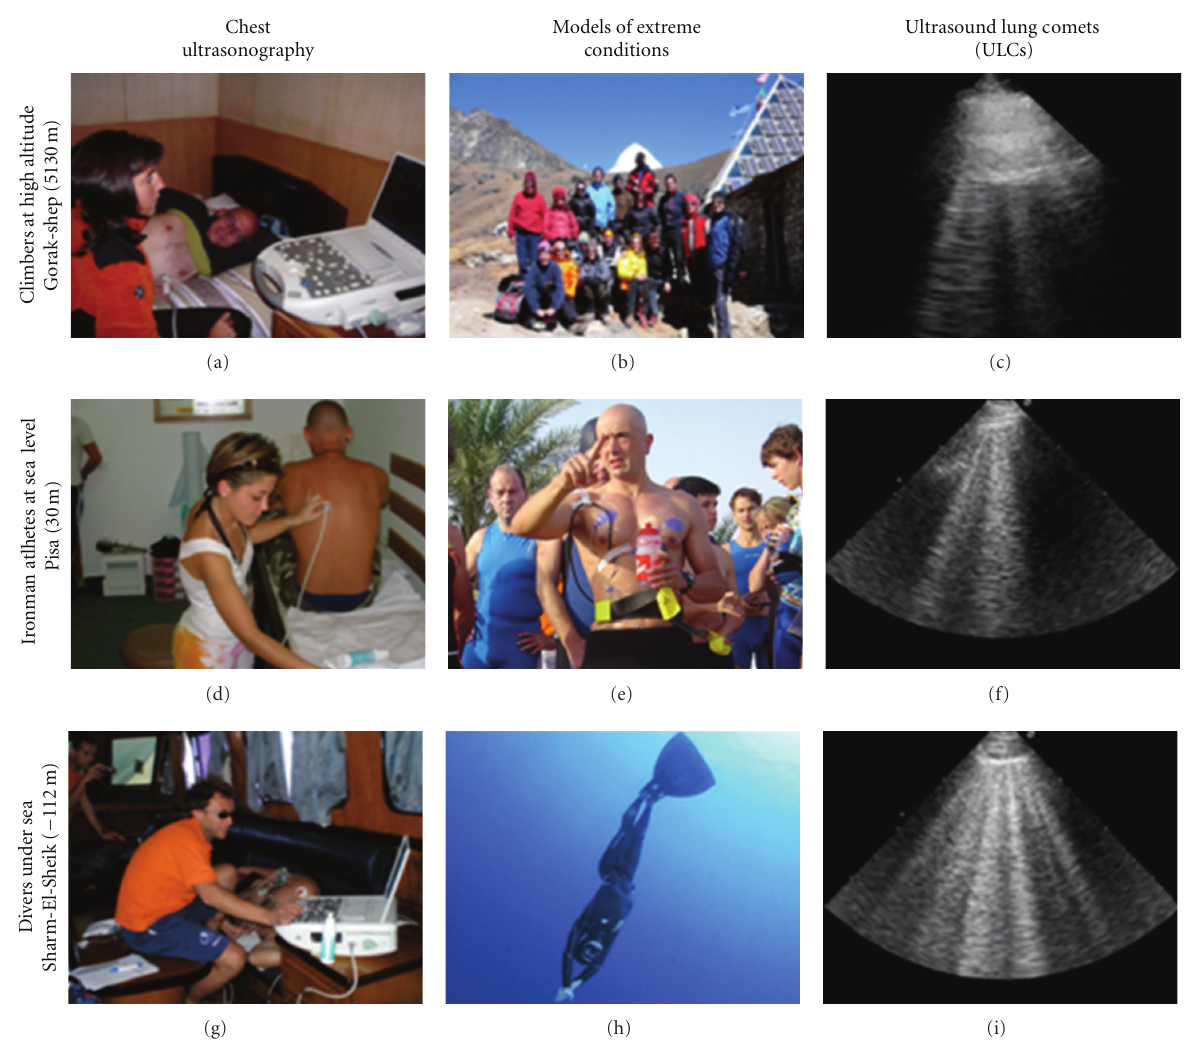
Figure 1: Three di ff erent models of extreme conditions: climbers at 5130 meters above sea level; ironman athletes at sea level; breath-hold diver at –112 meters under sea level. In all the above-mentioned conditions subjects were monitored by chest ultrasonography that showed the presence of